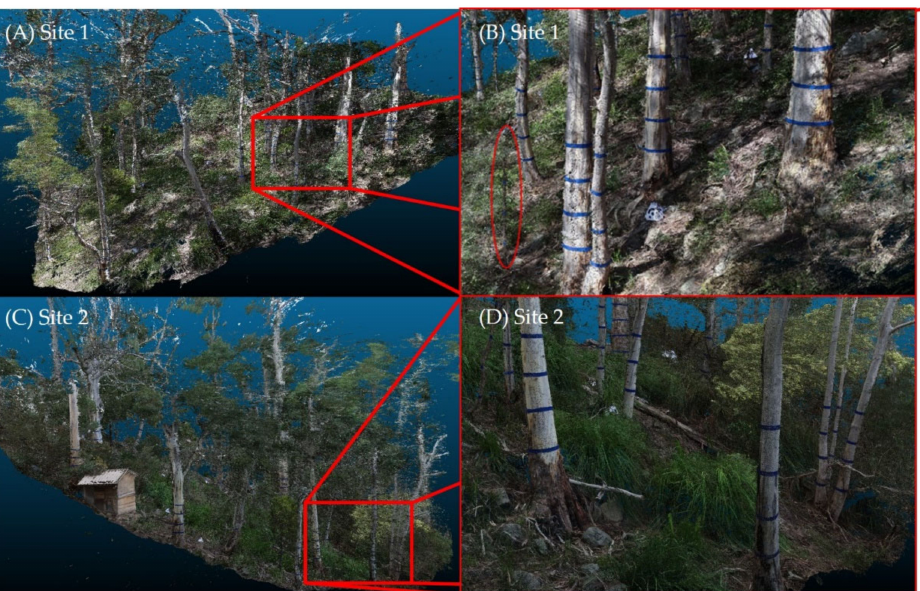
Figure 7. ( A ) Site 1 photogrammetric point cloud of the 13-m-radius plot area. ( B ) Shows a close-up view of Site 1 with a successfully reconstructed, 3-cm-diameter tree shown in the red ellipse. ( C ) Site